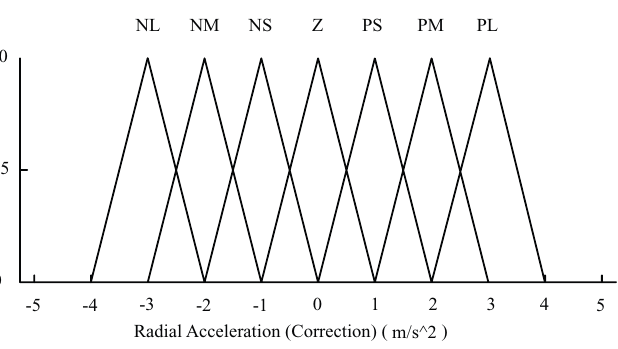
Fig. 9. Fuzzification of ˙ φ ( t ) .